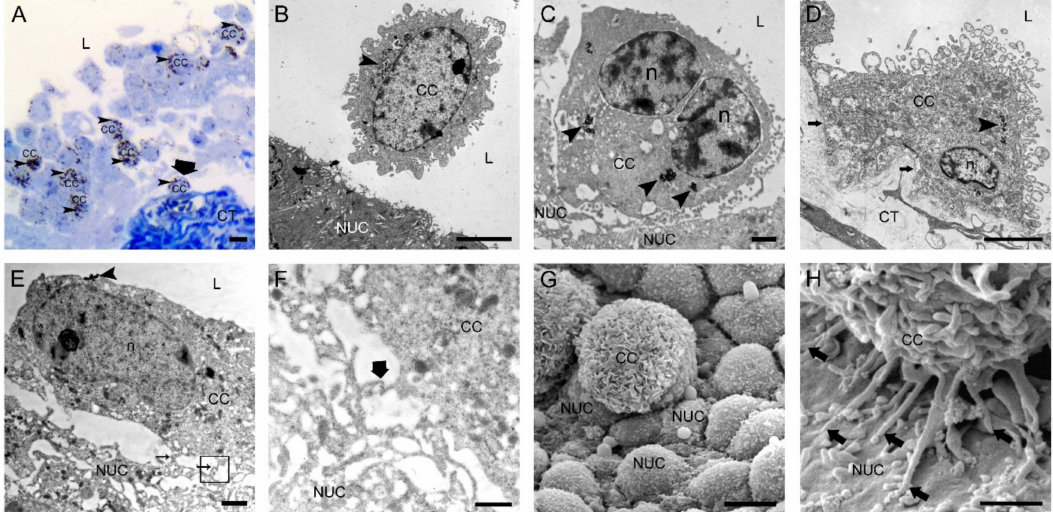
Figure 1. Two hours after intravesical application of MB49-GFP cancer cells with internalized nanoparticles. ( A ) Semi-thin section with numerous floating cancer cells (CC) in the lumen and one cancer cell attached to the exposed basal lamina (thick arrow). Toluidine blue staining. ( B ) Transmission electron micrograph of a floating CC in the lumen and close vicinity to a normal urothelial cell (NUC). ( C ) Transmission electron micrograph of a CC almost adhered to a less differentiated NUC exposed on the urothelial surface due to previously induced desquamation of superficial urothelial cells. ( D ) Transmission electron micrograph of a CC tightly attached to the exposed basal lamina (arrows) due to previously induced urothelial cell desquamation. ( E ) Transmission electron micrograph of a CC with its filopodia (thin arrows) adhered to a NUC at an early step of attachment. The area in the black frame is magnified in F. ( F ) A higher magnification view of